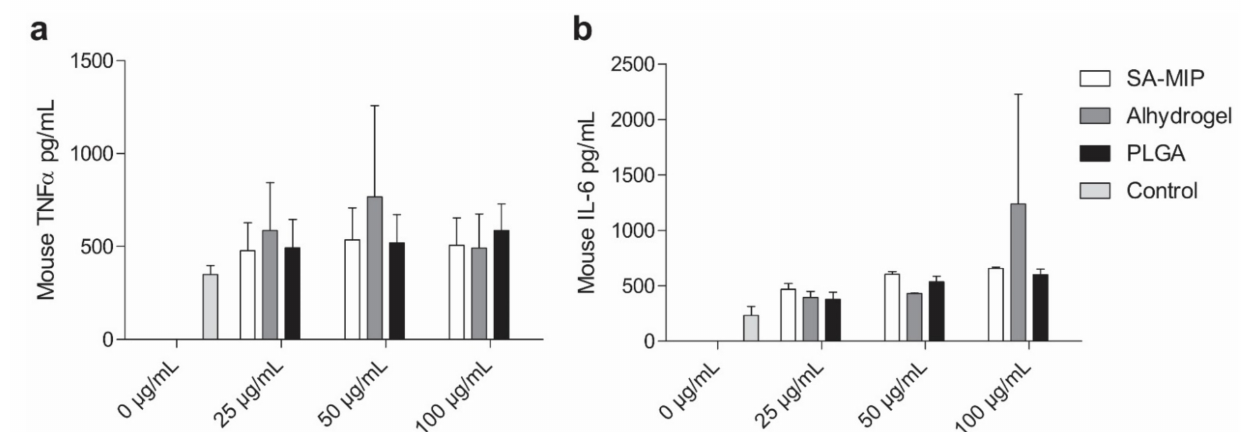
Figure 4. Secretion of TNF- α and IL-6 after incubation with SA-MIPs, Alhydrogel and PLGA. RAW 264.7 cells were cultured in medium alone or with additions of 0 µ g/mL, 25 µ g/mL, 50 µ g/mL or 100 µ g/mL SA-MIPs, Alhydrogel or PLGA, respectively, for 24 h at 37 ◦ C. Culture supernatants were assayed for TNF- α ( a ) and IL-6 ( b ) cytokines by ELISA. The results represent the mean of three independent experiments ± SD.